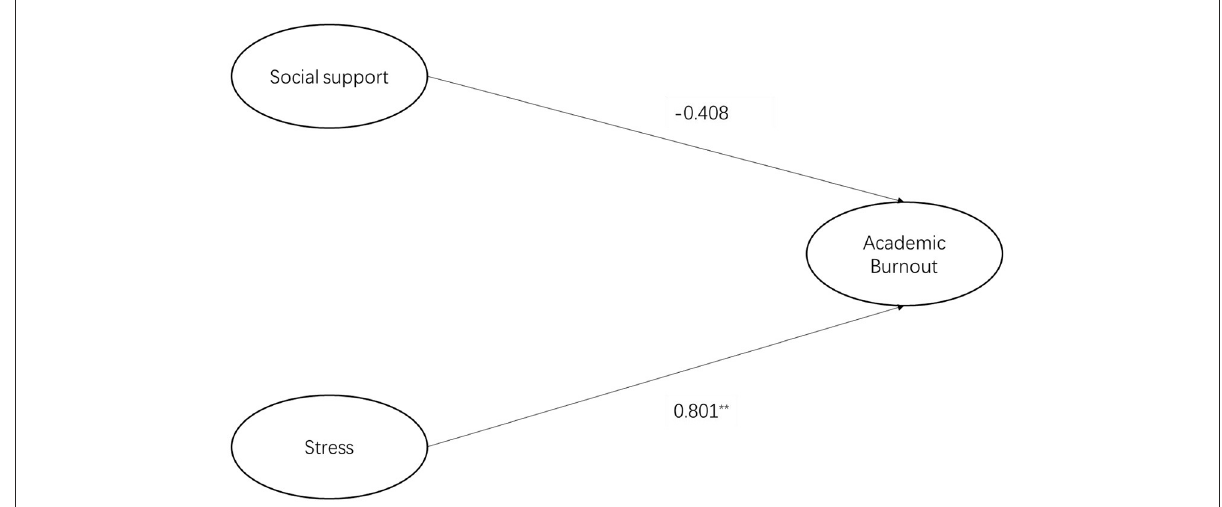
FIGURE2 SEM of stress, social support, and academic burnout.